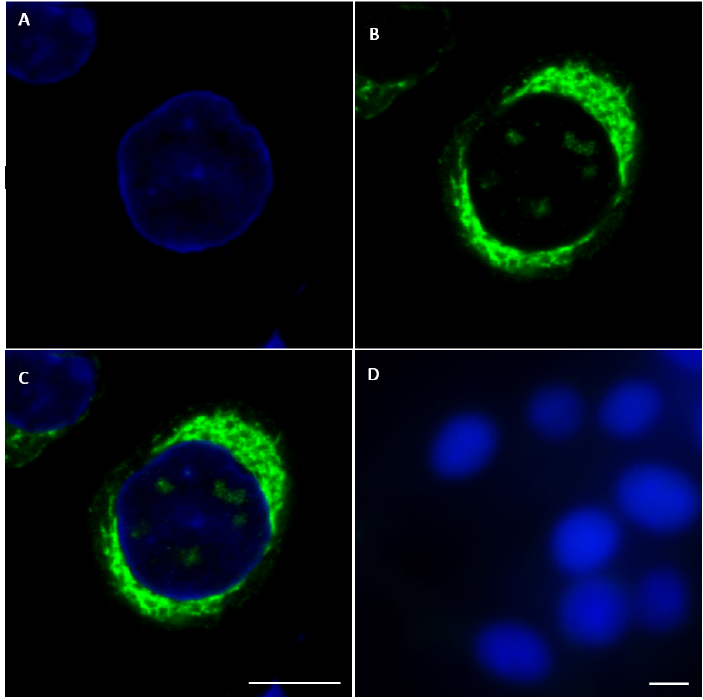
Figure 6. Confocal immunofluorescence microscopy analysis of NS5 expression in BTV-1-infected BSR cells. Anti-NS5 antibodies identify NS5 both in the cytoplasm and, to a lesser extent, in the nucleus. Mouse serum was adsorbed onto non-infected BSR cells to remove any potential non-specific antibodies. ( A ): nuclei coloured by DAPI; ( B ): NS5 signal identified by mouse anti-NS5 of BTV-1 and revealed by Alexa Fluor 488 (green fluorescence) conjugated anti-mouse Ig; ( C ): a merge of ( A , B ) panels; ( D ): non-infected BSR cells tested with anti-NS5 of BTV1 and Alexa Fluor 488 conjugated anti-mouse IgG (negative for NS5 detection). The scale bar represents 5 µm.